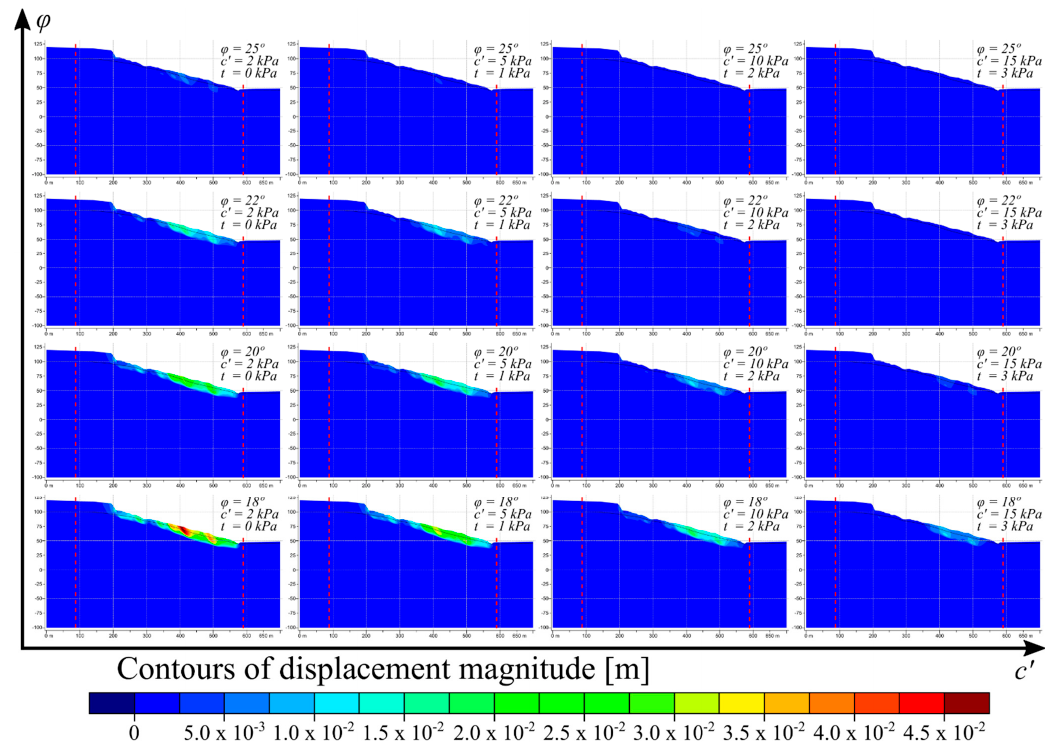
Figure 10. The magnitude of the displacement field from the numerical modeling with different parameters values combinations. The red dashed line in the model represents the point from which we artificially enlarged the model to reduce the boundary effect, thus not reflecting the actual topography. (high-resolution image available at https://doi.org/10.6084/m9.figshare.14920119.v2).